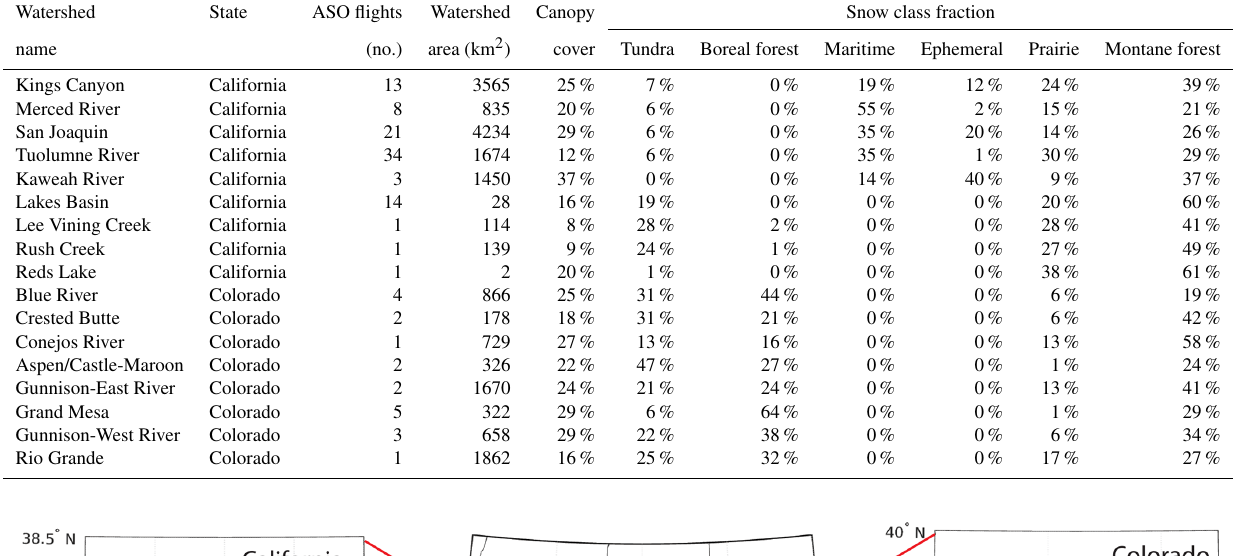
Table 1. Watershed and snow type characteristics corresponding to each study location. Watershed State ASO flights Watershed Canopy Snow class fraction name Prairie Montane forest Kings Canyon